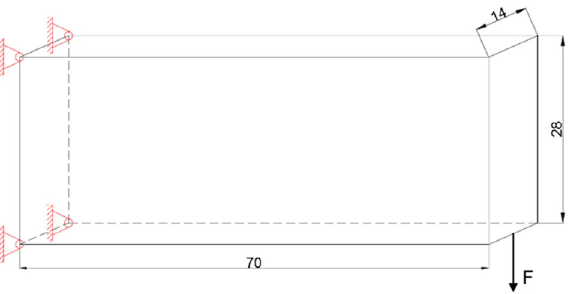
Figure 6. Design domain and boundary conditions for topology optimization of a three-dimensional cantilever